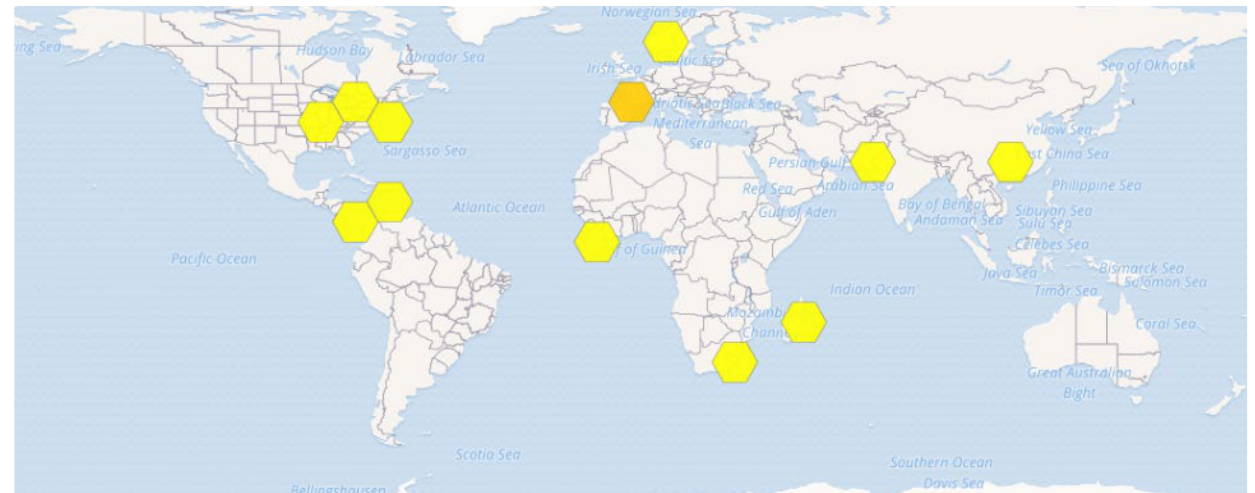
Fig. 3. Trichuris globulosa worldwide geolocation record data on request on the platform of the GBIF information system ( Trichuris globulosa Linstow, 1901 in GBIF Secretariat,